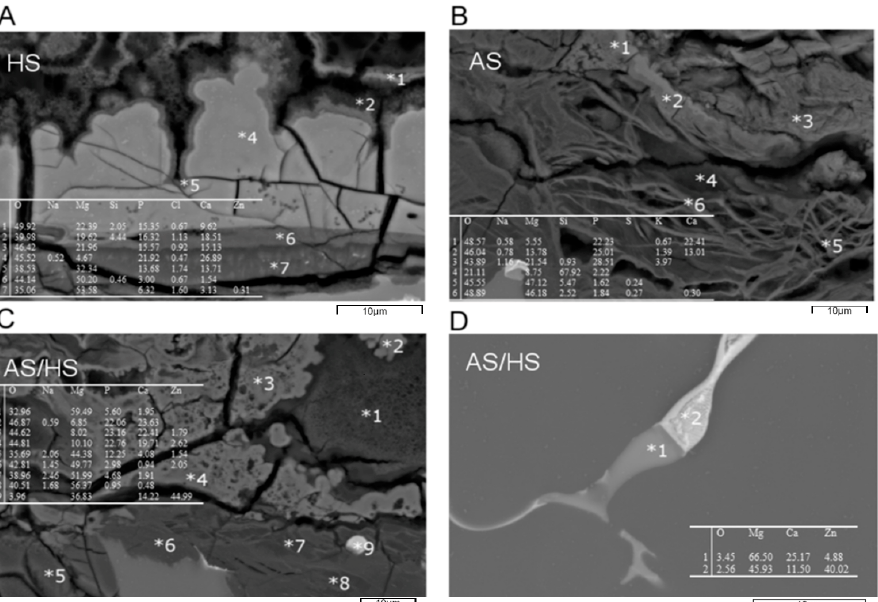
Figure 4. Cross-sectional scanning electron micrograph with EDX Analysis of Mg-0.6Ca-0.8 wt.% Zn Alloys for ( A ) 10 days in Hank’s solution, ( B ) 10 days in artificial saliva or ( C , D ) in AS/HS (5 days artificial saliva, 5 days Hank’s balanced solution).